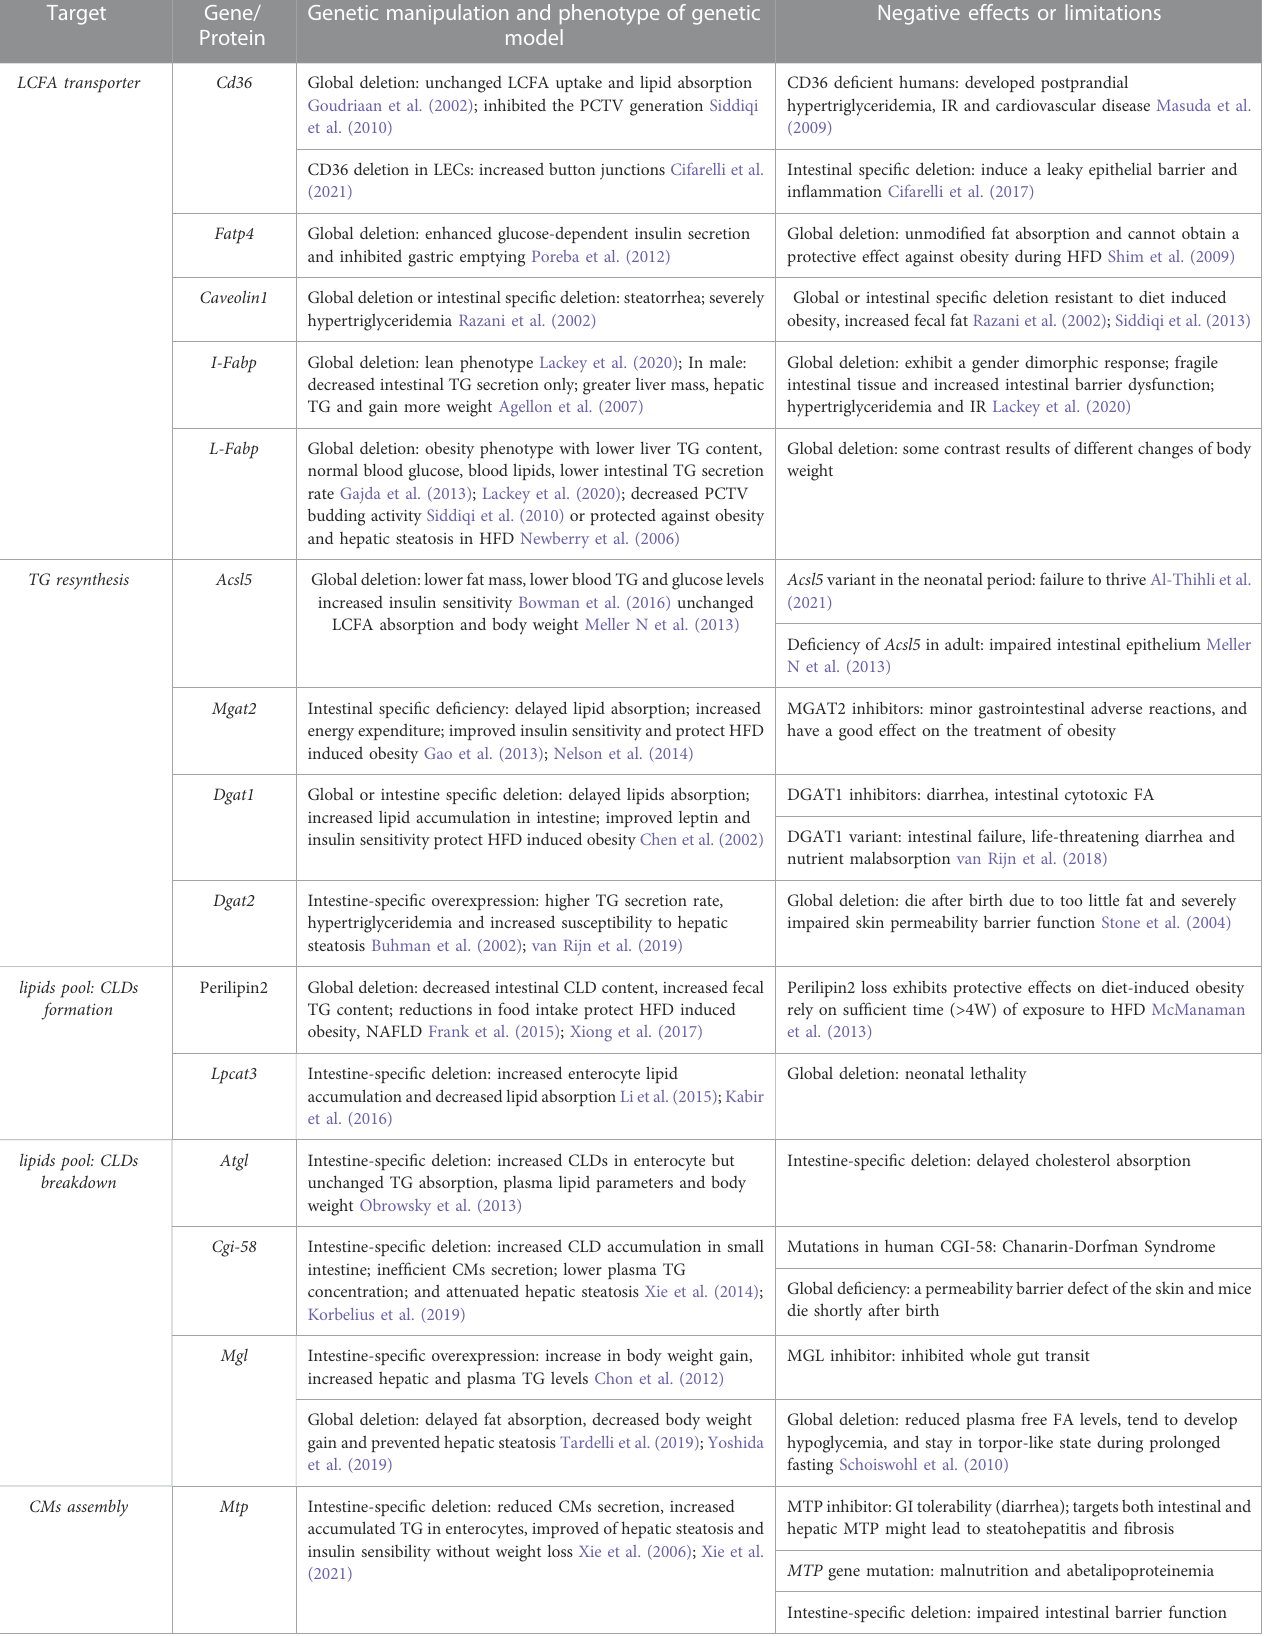
TABLE 1 Genetic or pharmacological manipulation of dietary lipid